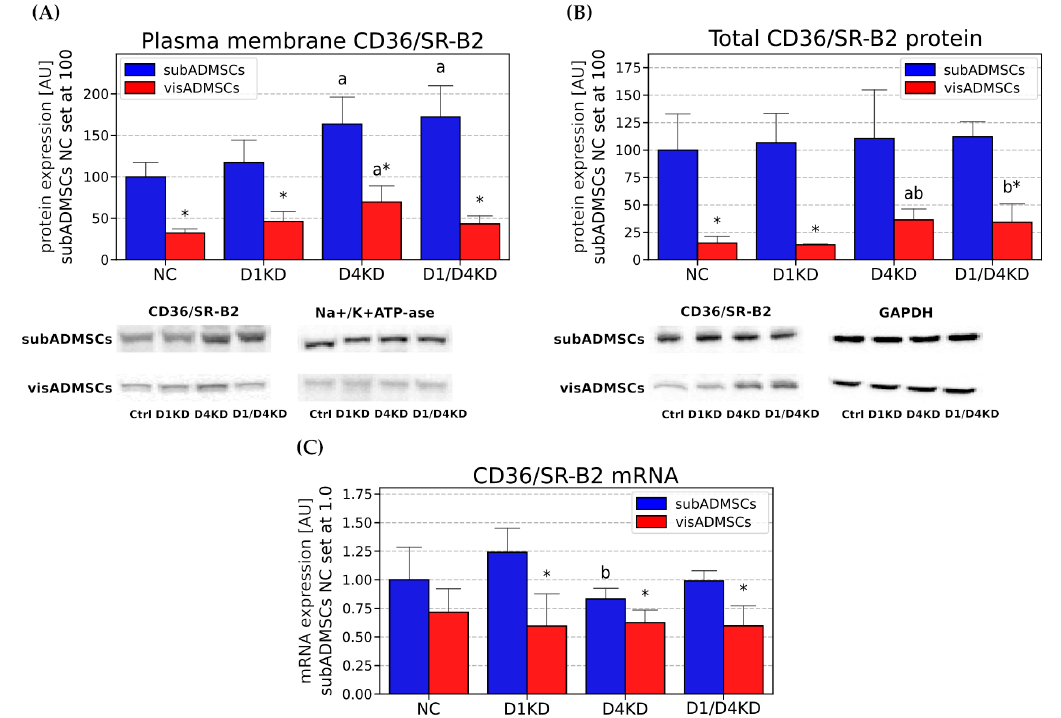
Figure 6. Plasma membrane ( A ), total protein ( B ) and mRNA ( C ) content of CD36/SR-B2 in TBC1D1- and/or TBC1D4- deficient adipocytes. Bars and whiskers represent the mean and SD respectively. Number of patients equals four (meas- urements taken in duplicate). Values are expressed in arbitrary units; the mean in subADMSCs' negative control was set at 100. Representative Western blot images are shown. a—difference versus NC ( p < 0.05); b—difference versus D1KD ( p < 0.05); c—difference versus D4KD ( p < 0.05); * p < 0.05 significantly different from visADMSCs. Designation of the groups: